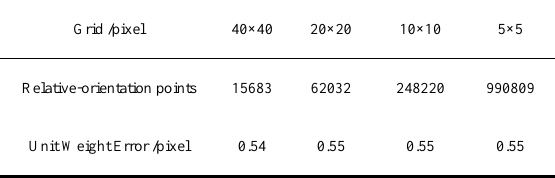
Table.1 Accuracy of relative orientation with dense matching point clouds